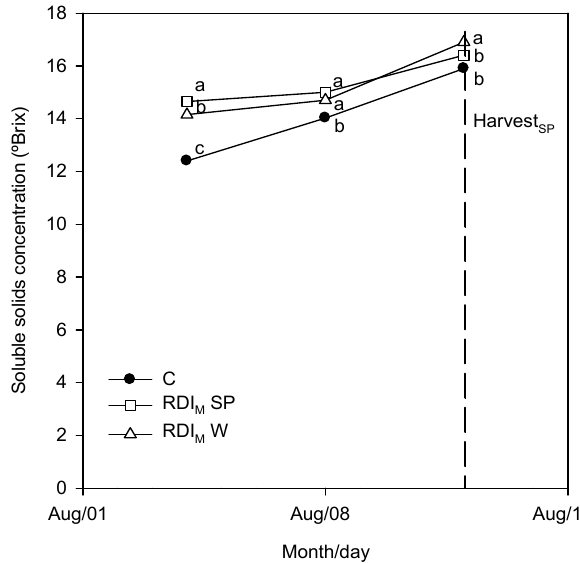
Figure 6. Evolution of soluble solids concentration ( ◦ Brix) during the pre-harvest period in 2016. Different letters indicate significant differences ( P ≤ 0.05).